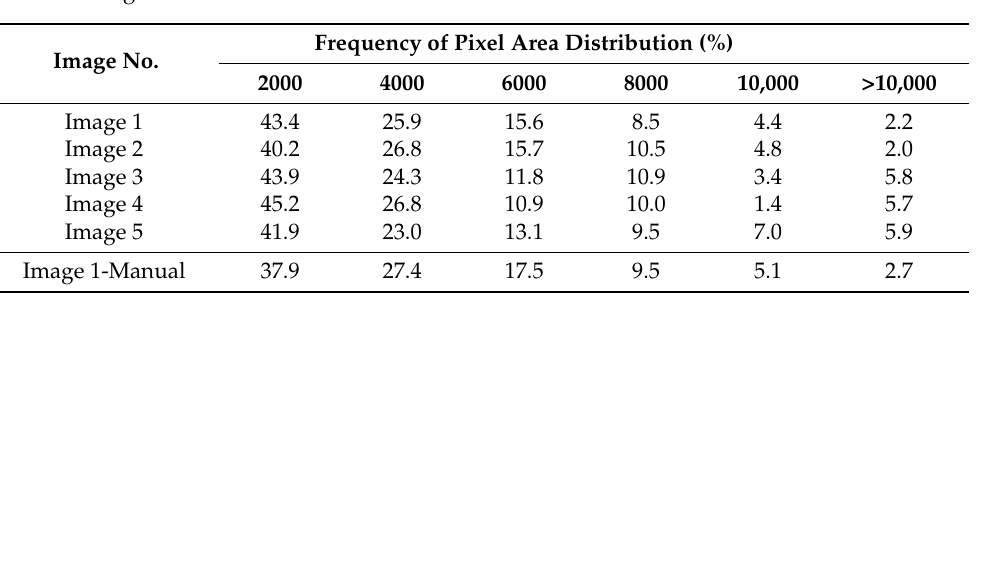
Figure 9. The processed results: ( a1 , b1 , c1 , d1 , e1 ) raw images of lab samples; ( a2 , b2 , c2 , d2 , e2 ) edge maps of input images; ( a3 , b3 , c3 , d3 , e3 ) contour maps with three filters results, where the light green contour is the fine region, the white contour is the connected rock region and the blue is single rock region. Table 1. The frequency of rock pixel area distribution from images 1 to 5, compared with manual results of image